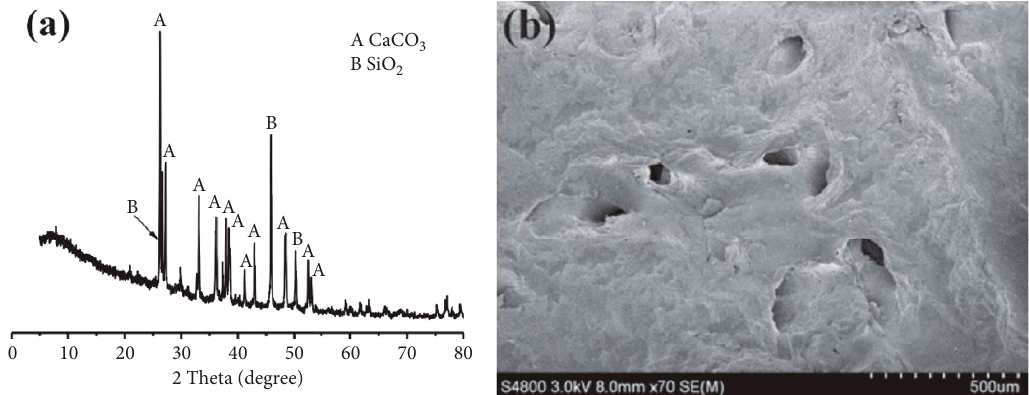
Figure 2: The XRD pattern (a) and the SEM picture (b) of a common coral aggregate [20]. Table 1: Typical tropical sea water chemical composition